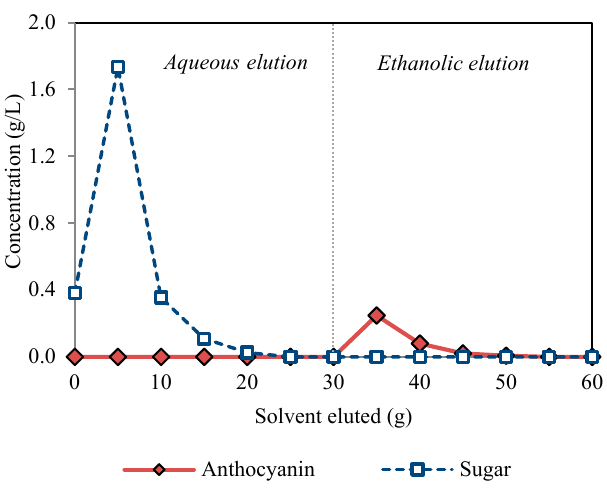
Figure 2. Elution profiles of sugars and anthocyanins after demineralized water (0–30 g) and acidified ethanol (30–60 g) elution of chokeberry extracts absorbed over Amberlite ® XAD7HP resin.